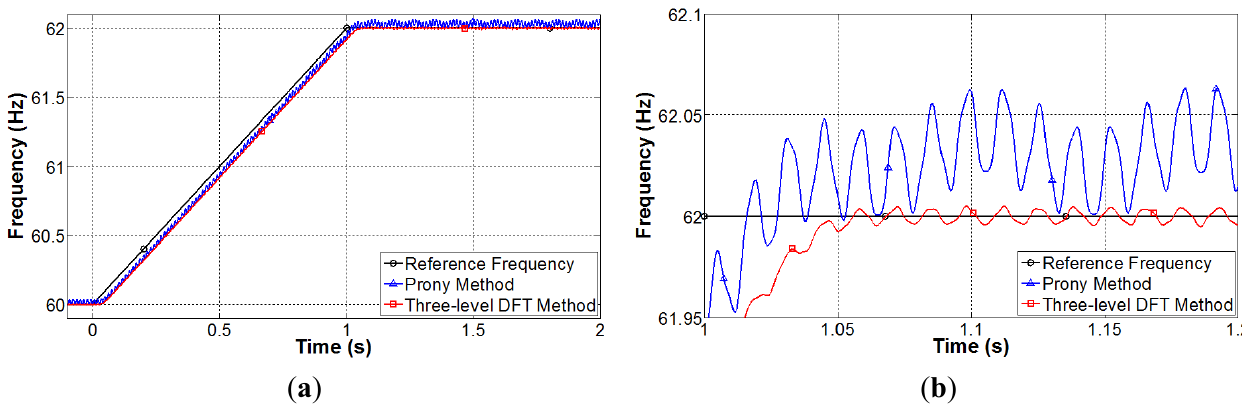
Figure 6. Estimation of a ramp-up frequency variation in the presence of harmonics and inter-harmonics. ( a ) Estimated frequency; ( b ) Close-up of the convergence.